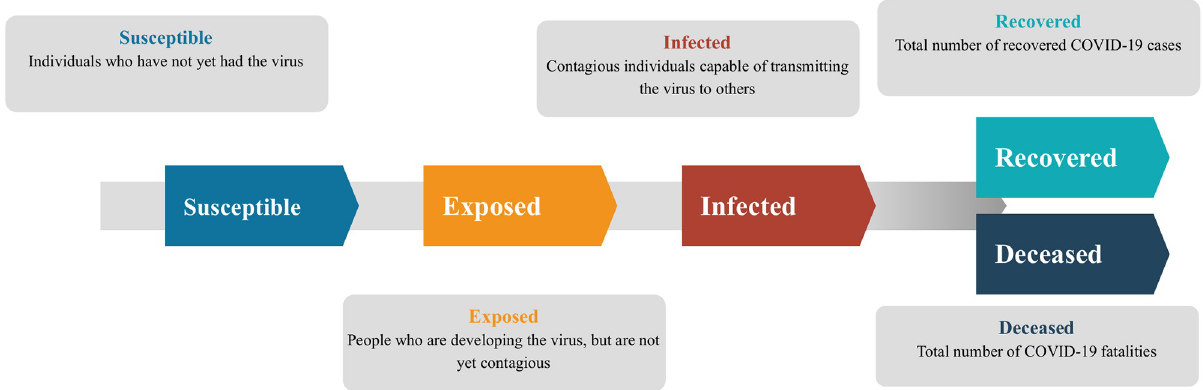
Fig 1. Schematic of the standard SEIRD epidemiological model. The total population is divided into five compartments: susceptible, exposed, infected, recovered, and deceased individuals.